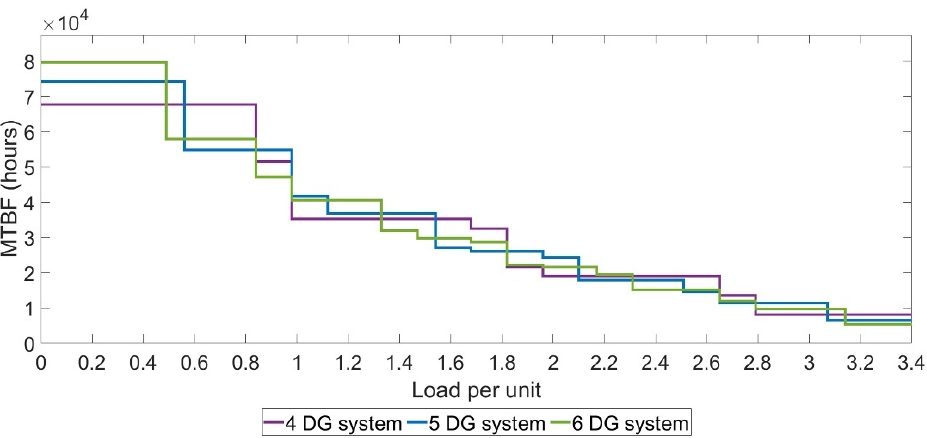
Figure 16. Reliability profiles of configurations for: ( a ) low-speed profile ( b ) medium-speed profile ( c ) high-speed profile.